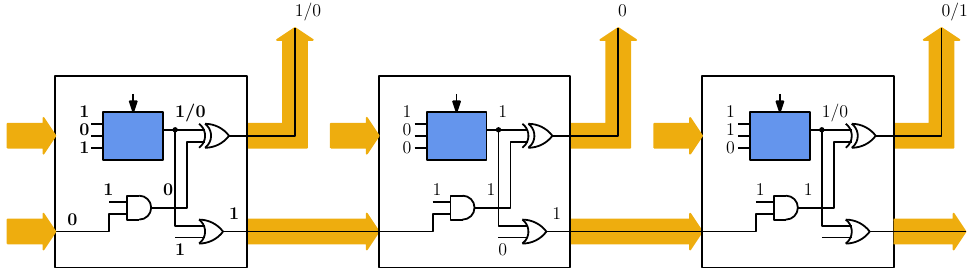
Figure 3. Time-frame expansion of a faulty synchronous sequential circuit featuring a cell with an injected